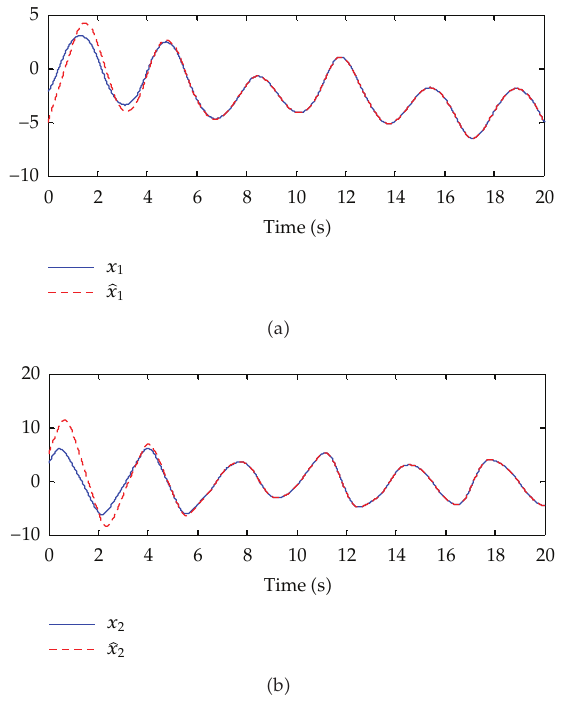
Figure 5: The time responses of x 1 and (cid:4) x 1 , x 2 and (cid:4) x 2